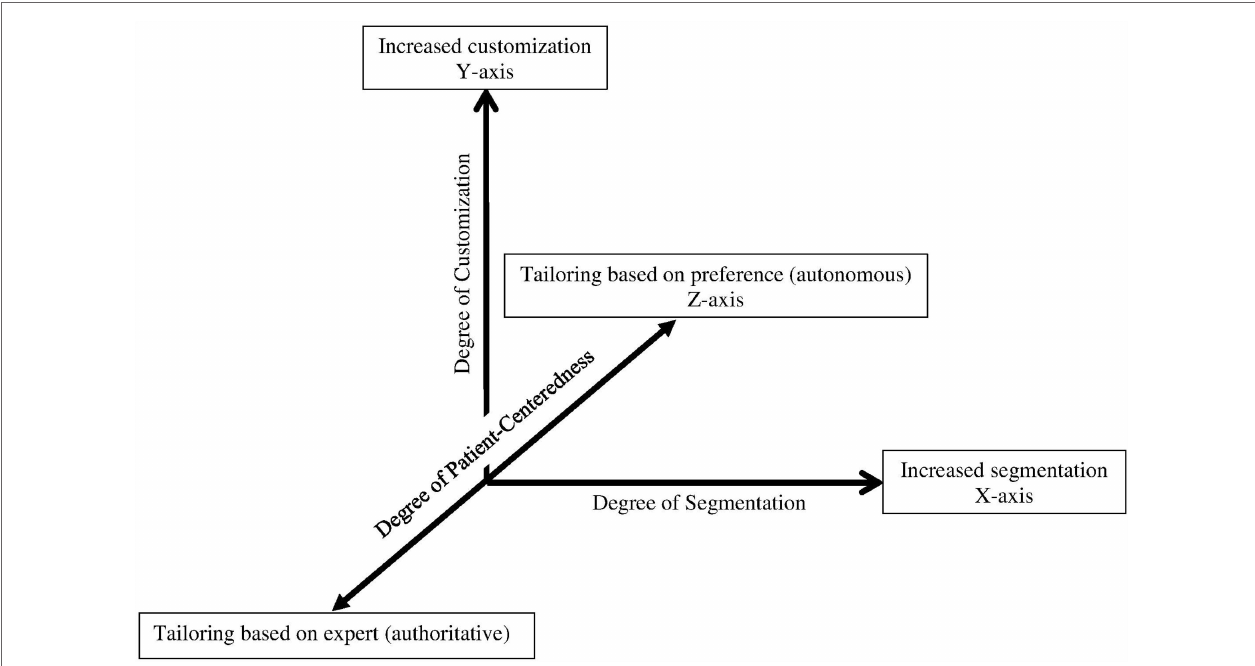
FiGURe 2 | Tailoring continuum to reflect the concept of patient-centered care: Adapted from Hawkins et al. (15)